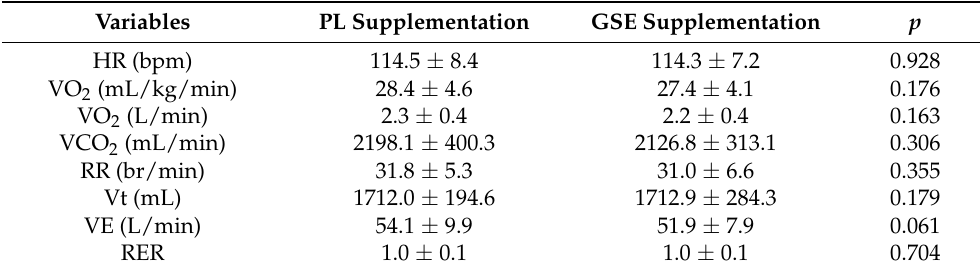
Table 3. Cardiorespiratory responses during the submaximal exercise of 50% of VO 2peak after PL and GSE supplementation.